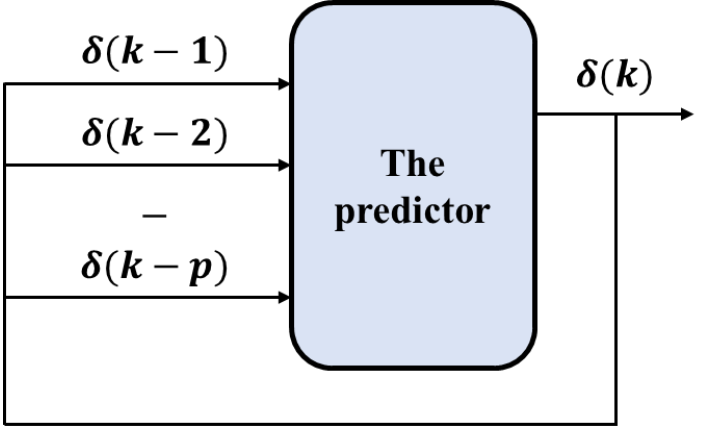
Figure 14. The topology of the NARNN predictor.